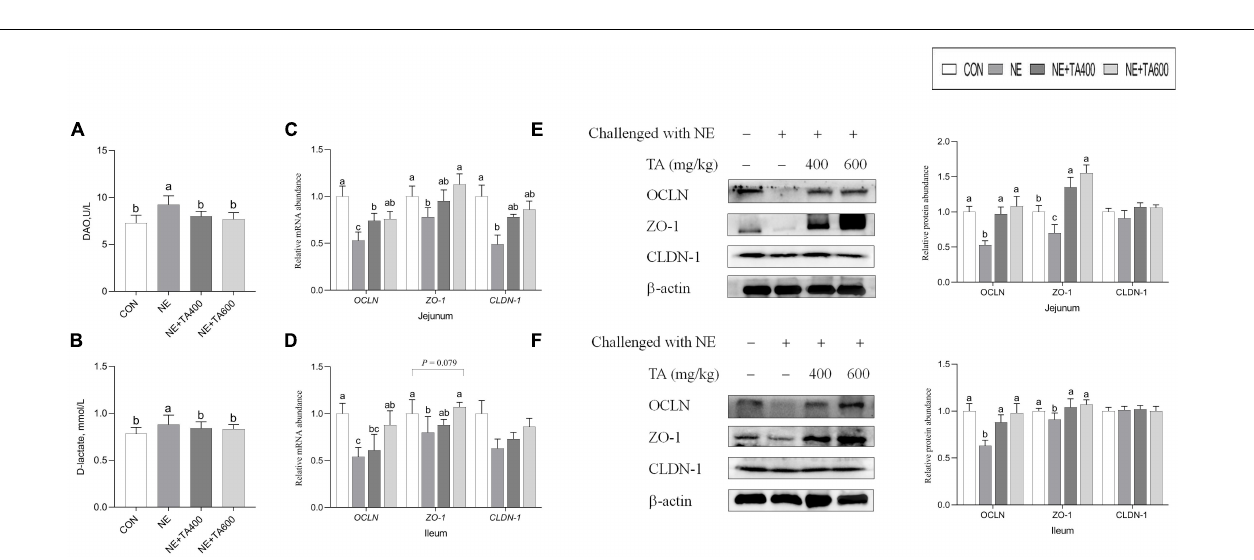
FIGURE 1 | The effects of TA on intestinal macroscopic changes and lesion score and the morphology of subclinical NE broilers. (A) Images of jejunal tissues; (B) images of ileal tissues; (C) jejunum lesion score; (D) ileum lesion score; (E) hematoxylin and eosin staining; (F) VH, CD, and VH/CD of intestine. Values were expressed as mean with standard error represented by vertical bars. a − c Means with different letters differ significantly among the groups ( P < 0.05). VH, villus height; CD, crypt depth; TA, trans -anethole; NE, necro-hemorrhagic enteritis.